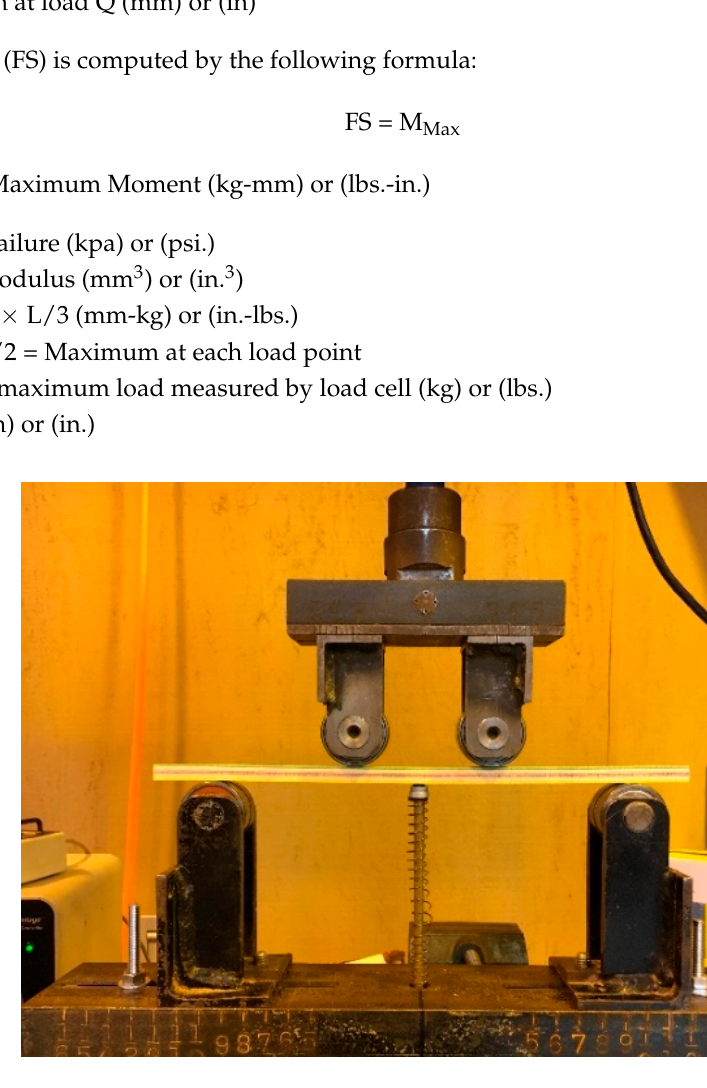
Figure 9. Third point bending setup in the face wise direction showing load points and linear variable differential transformer (LVDT) measuring deflection at center line.